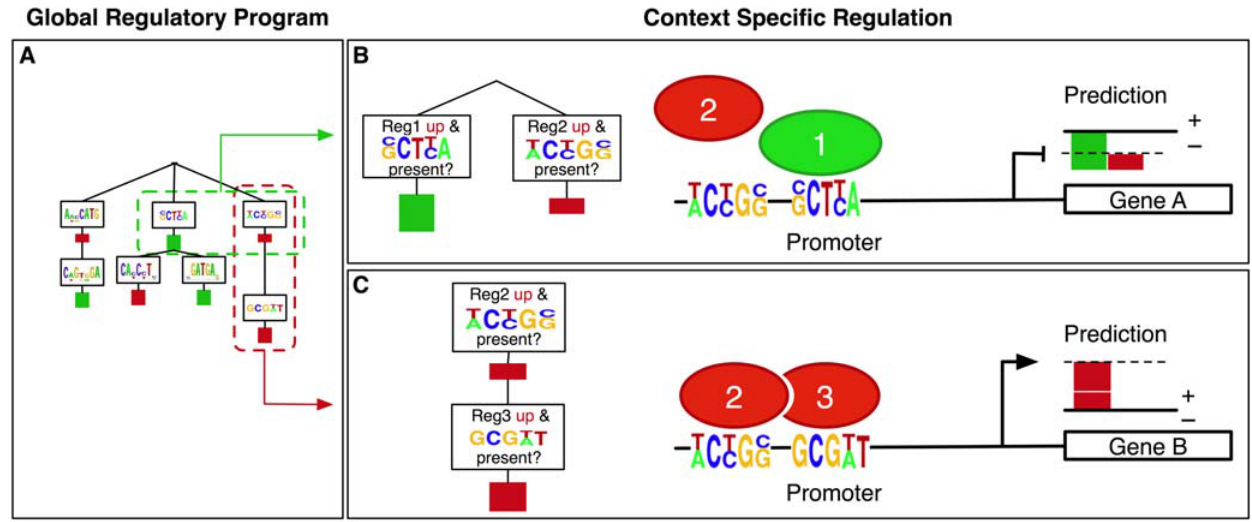
Figure 3. Simplified example showing how the regulatory program learned by MEDUSA predicts context-specific up/down gene expression. MEDUSA learns a global regulatory program described by an alternating decision tree. A simple regulatory program is shown in part A of the figure, along with the prediction it makes in two contexts, indicated as context B (top right) and context C (bottom right). The interaction between a regulator and a motif and the effect on targets is described by a decision node, which contains a logical condition to be tested, e.g., ‘‘Is regulator i up in the experiment and is motif i present in the promoter?’’, and by the contribution that this motif/regulator pair makes to the up/down prediction of target gene expression if the logical condition is true, which is indicated by a colored bar. Contributions to upregulation of targets are shown in red and downregulation of targets in green. Combinatorial regulation is encoded by the tree structure: we obtain a prediction score for the up/down regulation of a target gene in a given experimental condition by starting at the root and recursively working downwards in the tree, seeing which prediction nodes are reachable by answering ‘‘yes’’ to logical conditions and summing all score contributions for the nodes visited. (Context B) In the first context, both Reg 2, a transcriptional activator, and Reg 1, a repressor, are expressed, and the promoter of gene A contains the motifs associated by the regulatory program to both these regulators. The regulatory program computes the prediction score by summing the larger contribution of the repressor (green bar) with the smaller contribution of the activator (red bar) to obtain a negative prediction score (indicated by the dashed line on the far right), i.e., gene A is predicted to be downregulated. (Context C) In the second context, both the activator Reg 2 and a co- factor, Reg 3, are expressed and can bind to the promoter of gene B based on the presence of the associated motifs in the regulatory program. The logic of the tree requires that the condition involving Reg 2 must hold before the contribution of the node containing Reg 3, at the next level of the tree, can be counted. Here, both conditions hold, and the regulatory program adds two positive contributions to obtain a confident prediction that gene B will be upregulated.